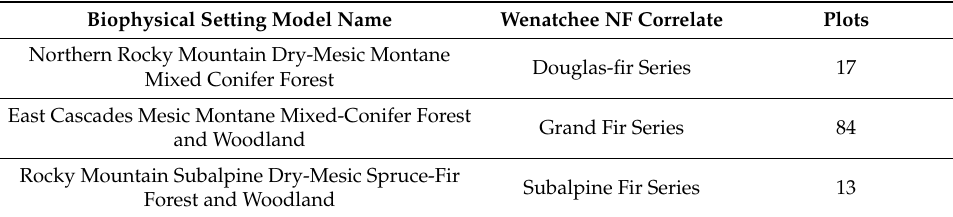
Table 3. Cross-walk between the BpS Model and Wenatchee NF Correlate from